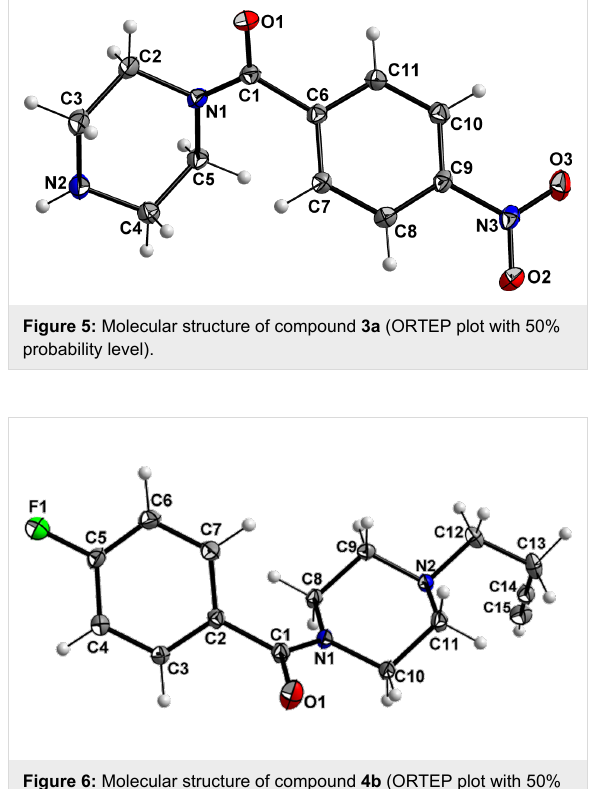
Figure 6: Molecular structure of compound 4b (ORTEP plot with 50% probability